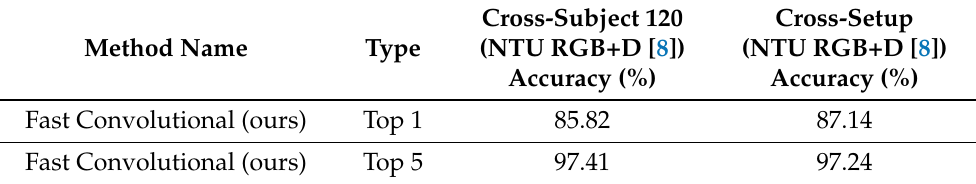
Table 6. Performances obtained by the convolutional model for the NTU RGB+D dataset [8] from the perspective of Top 1 and Top 5